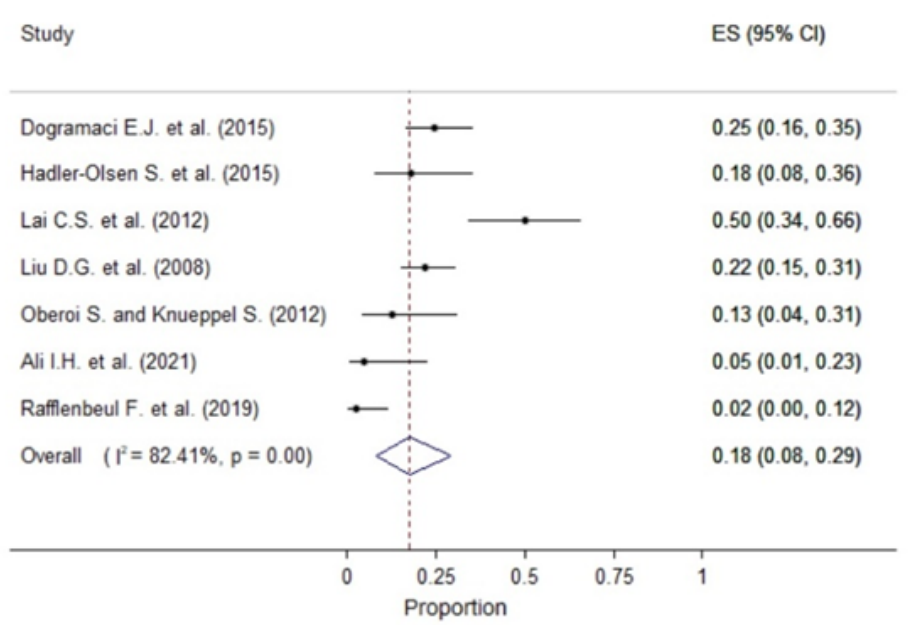
Figure 4. Forest plots with the prevalence of root resorption for patients with impacted canines by severity [26–32].